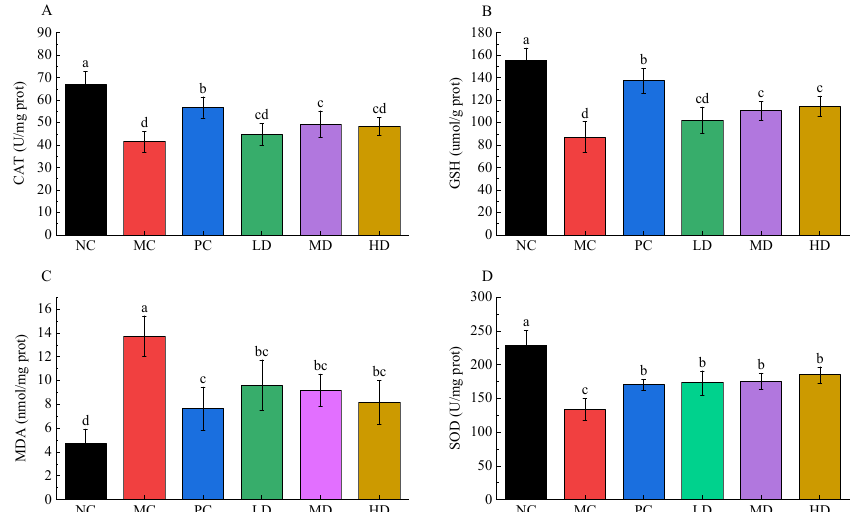
Figure 4. Liver oxidative stress in mice fed experimental diets for 30 days. ( A ) CAT; ( B ) GSH; ( C ) MDA; ( D ) SOD. Values are displayed as a bar chart plot with means (expressed as ‘+’), n = 3. a–d: bars with different letters are significantly different at p < 0.05 by Tukey’s post hoc test. NC: normal group (normal feed, 0.9% saline); MC: model group (HFD, 0.9% saline); PC: positive group (HFD, 0.5 mg/mL xuezhikang capsules); LD: RFV low dose group (HFD, 10% RFV); MD: RFV medium dose group (HFD, 30% of RFV); HD: RFV high dose group (HFD, 50% of RFV).